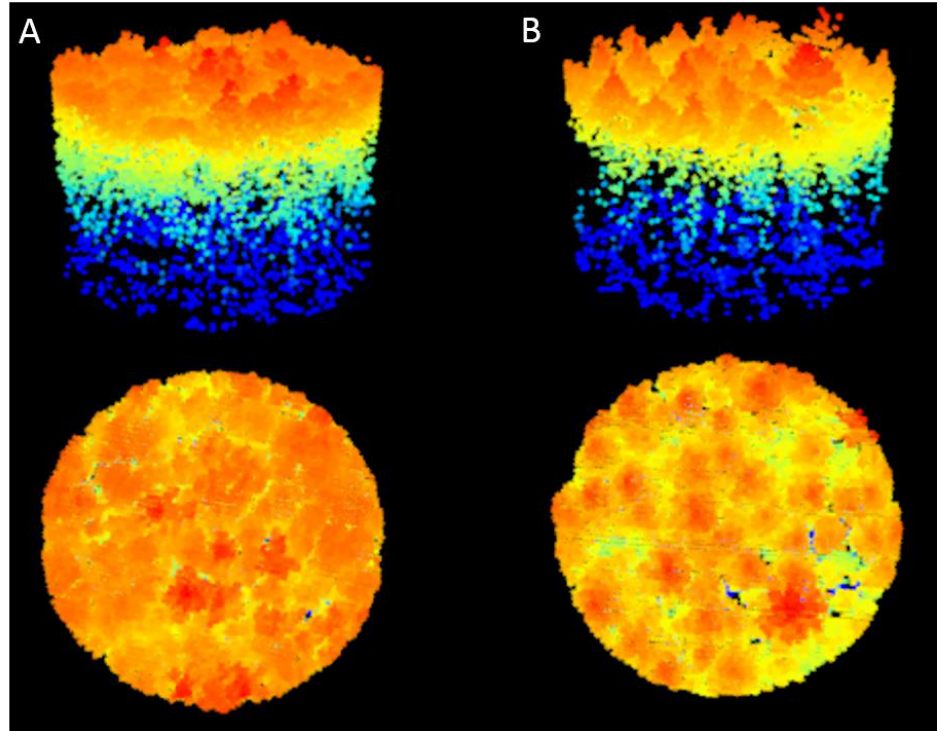
Figure 7. G-LiHT LiDAR point cloud comparison highlighting the differences in structure between a high-evenness broadleaf-dominated stand ( A ) and a low-evenness conifer-dominated stand ( B ). Warmer colors represent higher points in the canopy. The conifer-dominated stand exhibits higher canopy rumple, and uniformity of crown shape. The conical, less-plastic shape of conifer crowns may also reduce canopy space filling efficiency.